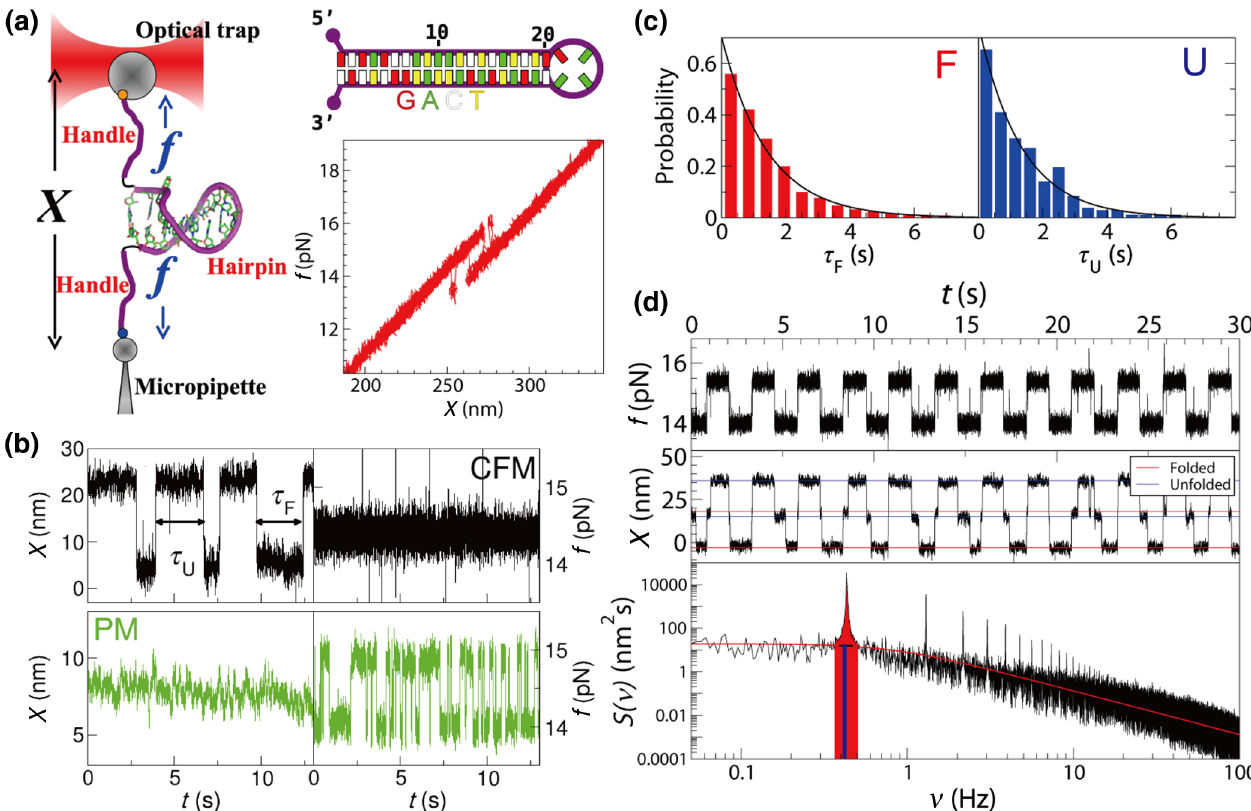
FIG. 1. Experimental setup, hopping, and SR experiments. (a) Illustration of the experimental system (left), DNA sequence of the two-state hairpin H1 (upper right, sequence shown in color code), and experimental force-distance curve for H1 obtained from a pulling experiment (lower right). (b) Typical force and extension traces of the hopping experiments for H1 obtained in CFM (upper) and PM (lower). (c) Probability distributions of the residence times for H1 in the F (red) and U (blue) states obtained from the hopping experiments at f ¼ f c ’ 14 : 5 pN in the CFM. The black curves show the exponential fit, ð 1 =a Þ exp ð(cid:1) (cid:1)=a Þ , to the data, with a ¼ 1 : 42 s ( a ¼ 1 : 34 s ) for the F (U) state, respectively. (d) Typical force and extension traces (upper and middle) obtained by applying an oscillating-force protocol with amplitude A ¼ 0 : 7 pN and frequency (cid:2) os ¼ 0 : 4 Hz around the coexistence force f c ’ 14 : 5 pN . In the lower panel, we show the measured power spectrum, S ð (cid:2) Þ , calculated by fast Fourier transform of X ð t Þ with window size N ¼ 2 17 shown in the middle panel. The sampling rate of the instrument is 1 kHz. The red area is the output signal [OS, Eq. (2)], and the vertical blue bar represents the background noise [BN, Eq.